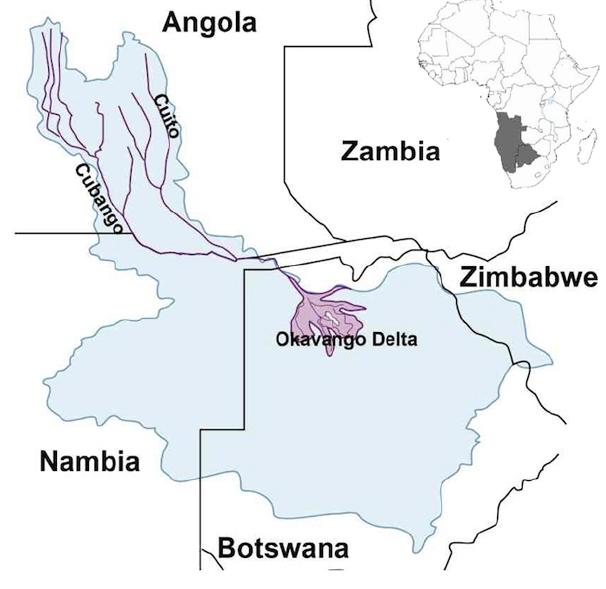
Fig. 1. Map of the Okavango River